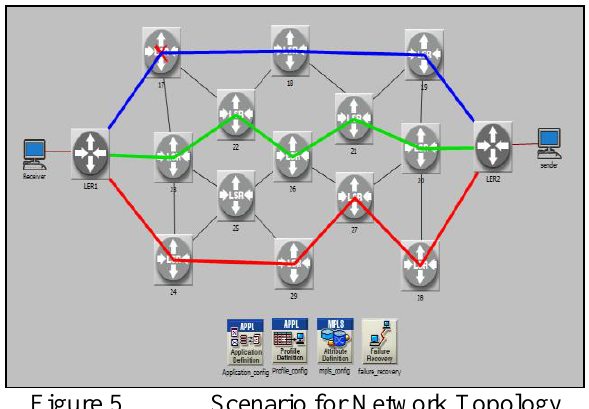
Scenario for Network